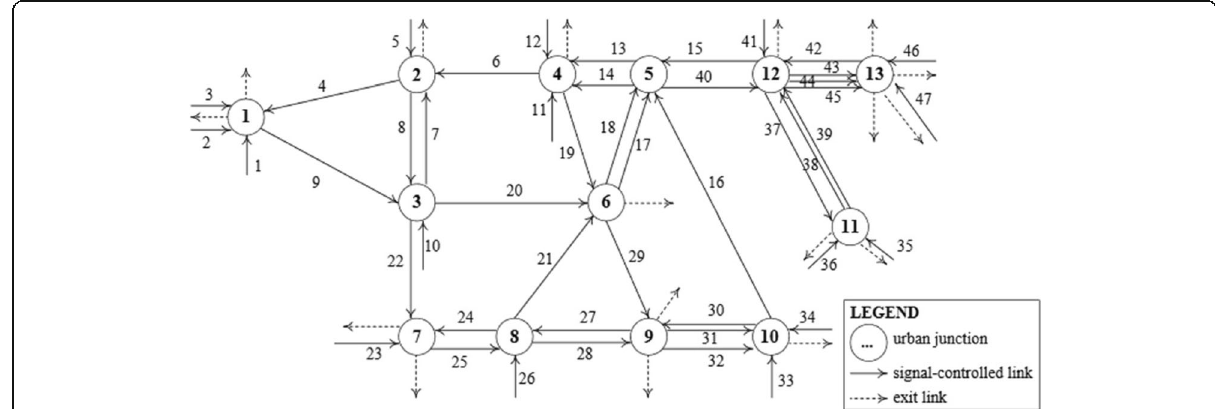
Fig. 1 The urban network of the city center of Chania,